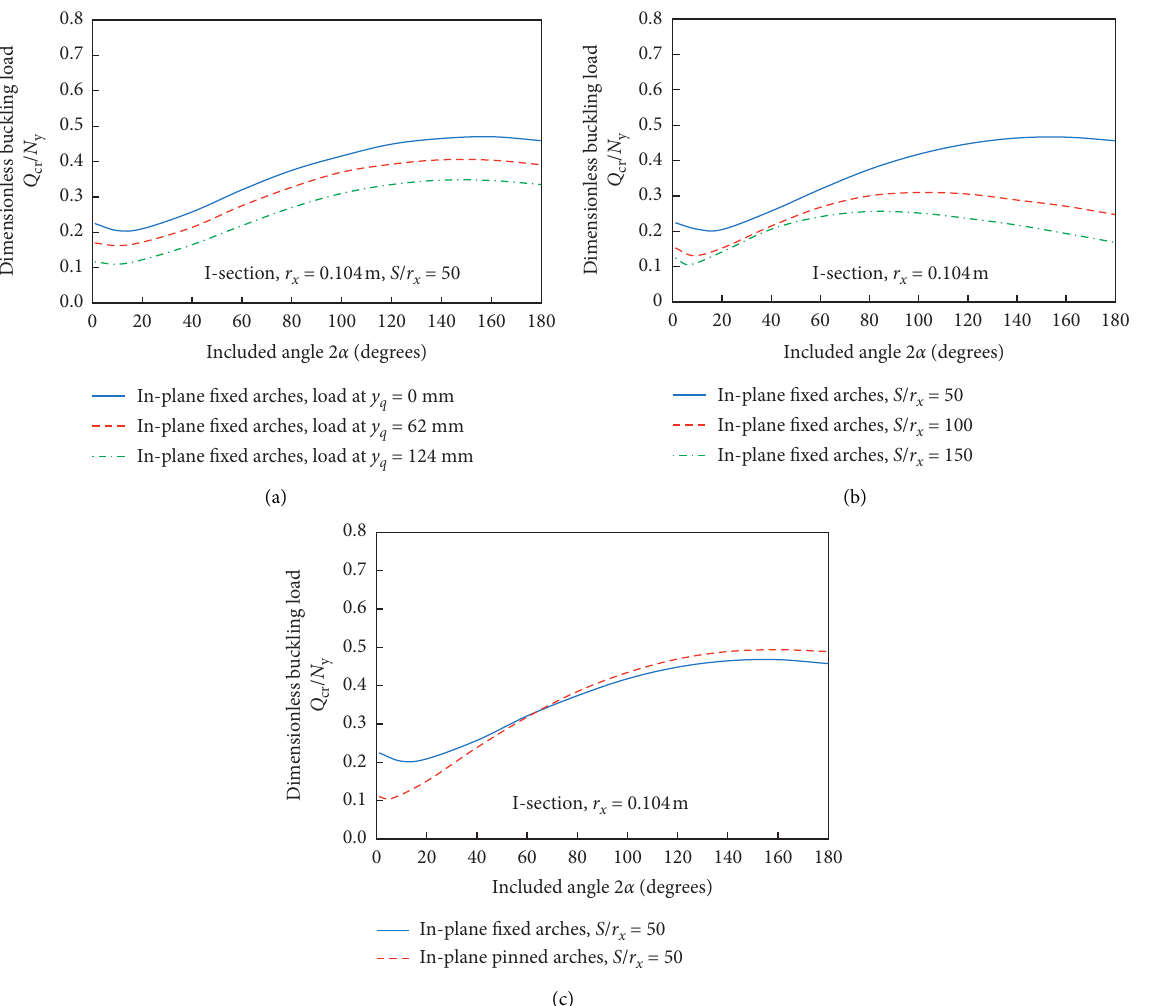
Figure 5: Lateral-torsional buckling loads effects of (a) load height, (b) slenderness, and (c) in-plane boundary conditions